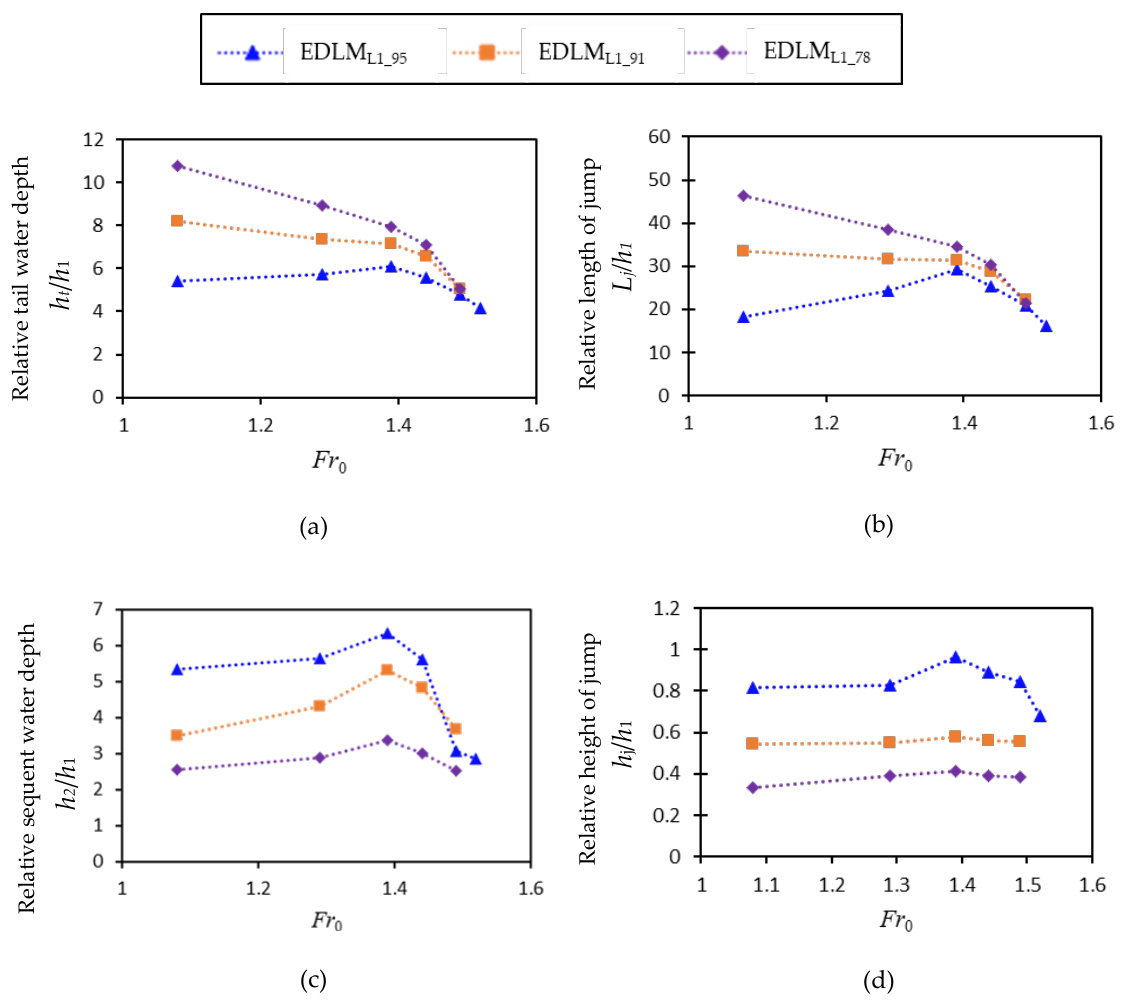
Figure 7. Hydraulic jump parameters related to initial Froude number ( Fr 0 ): ( a ) relative length of the jump, ( b ) relative tailwater depths, ( c ) relative sequent depths, and ( d ) relative jump heights.